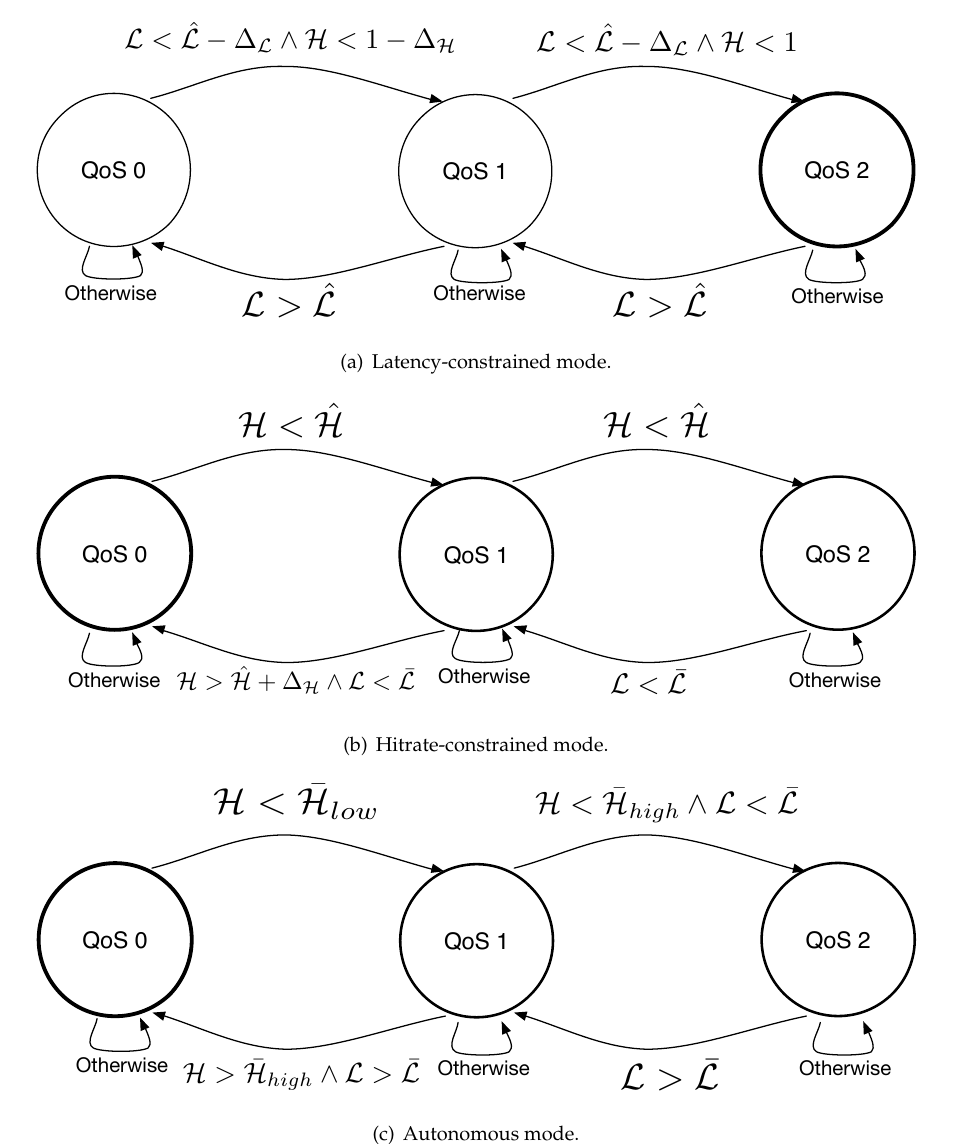
Figure 6. Finite state machines used to model the controller behavior for the three different operational modes: ( a – c